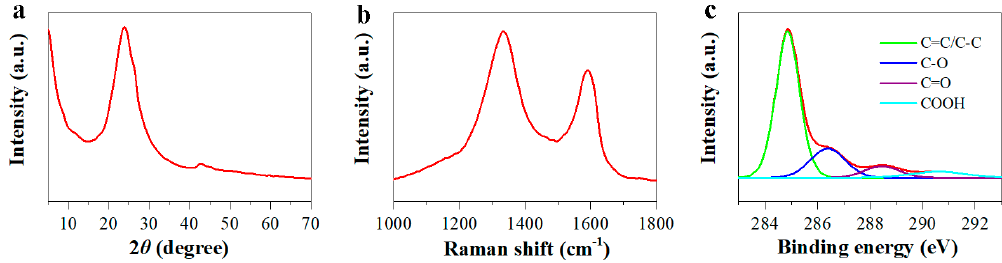
Figure 2. XRD ( a ), Raman ( b ) and C 1s XPS ( c ) patterns of GH.